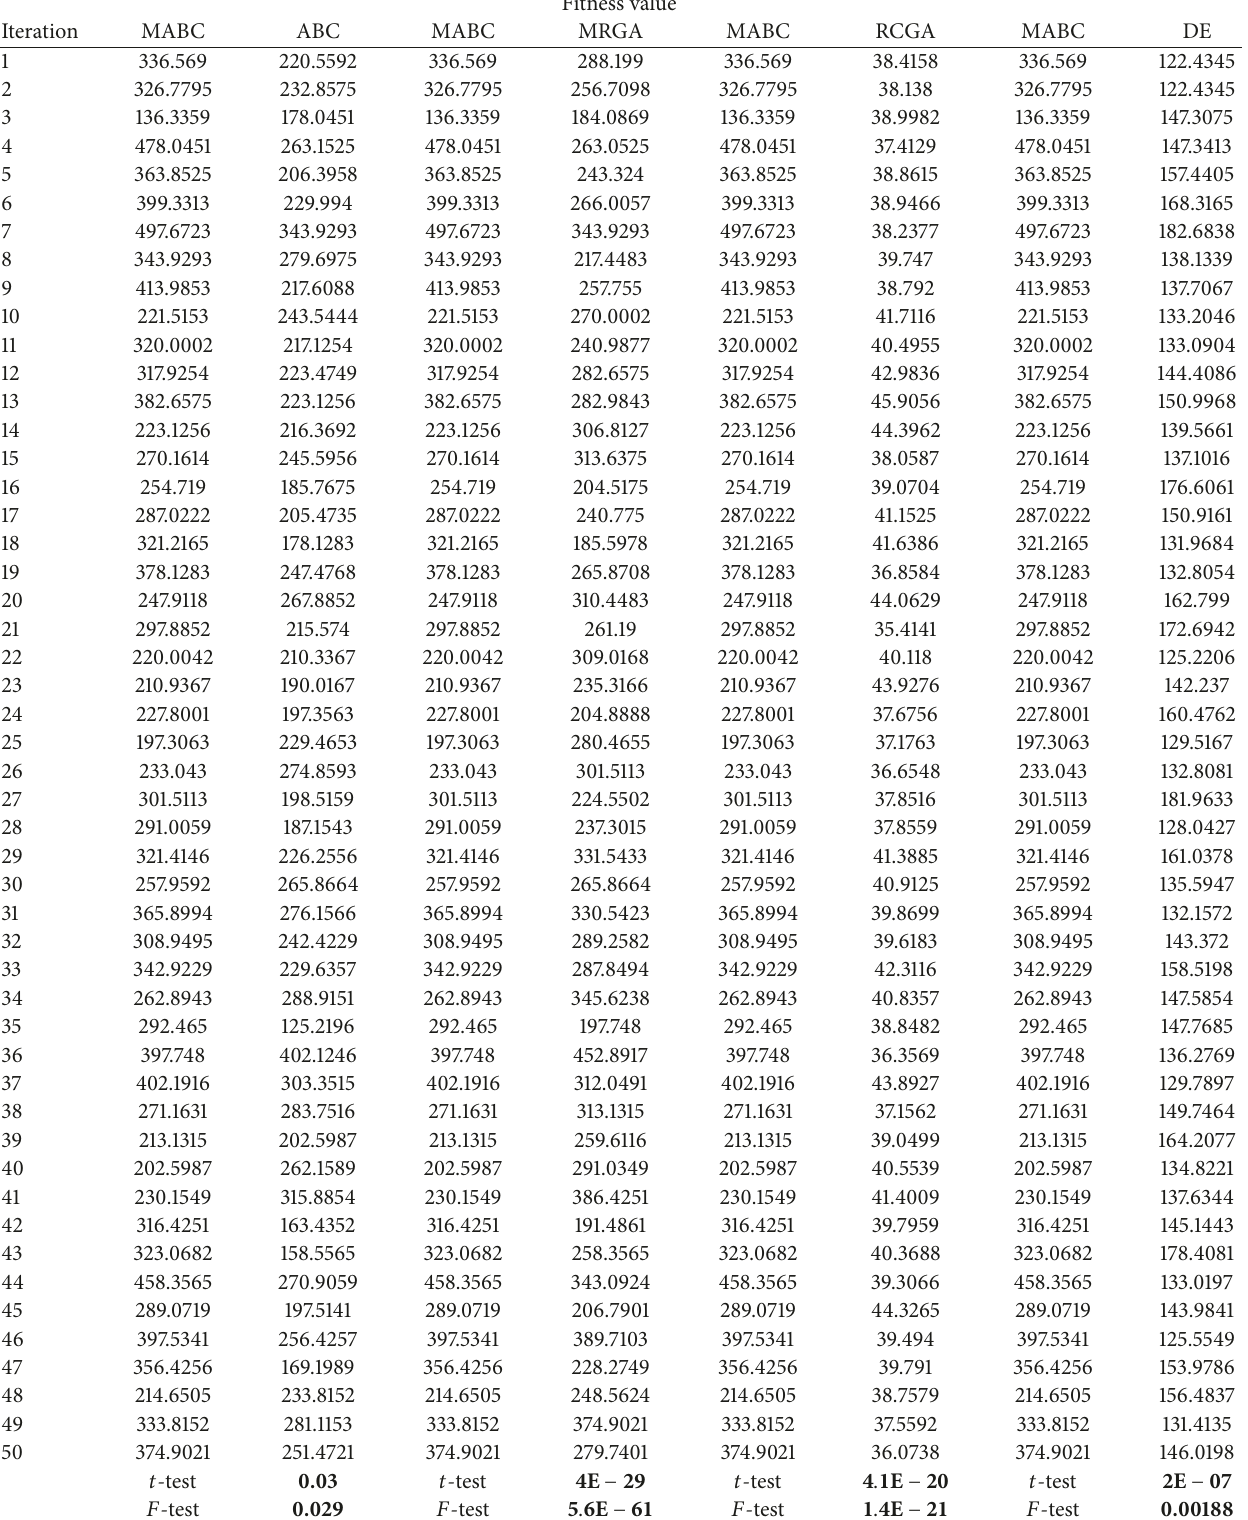
Table 6: Comparison of results obtained for their fitness value by MABC, ABC, MRGA, RCGA, and DE with 50 test numbers getting in 200th-generation